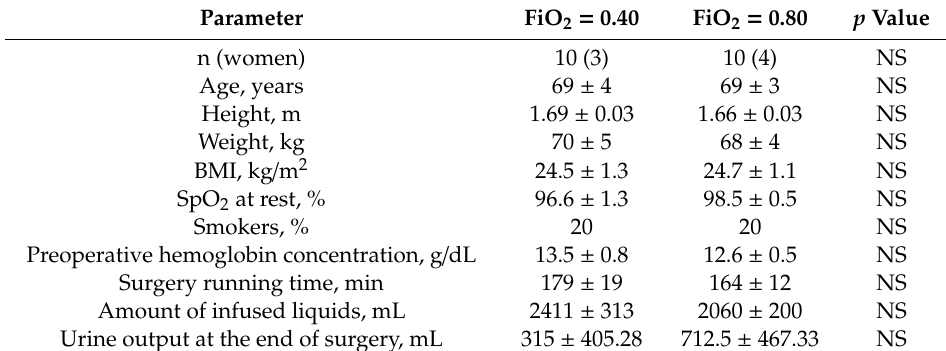
Table 1. Demographic and anthropometric characteristics of the study population.